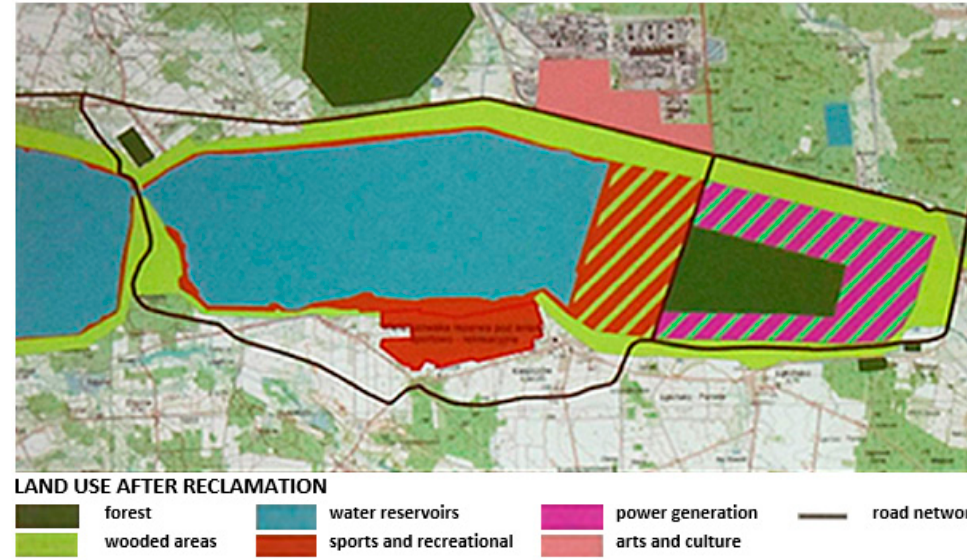
Figure 9. Planned land uses after the recultivation of the KWB Be ł chatów mine in the municipality of Kleszczów (source: materials from the Kleszczów Municipal Office).